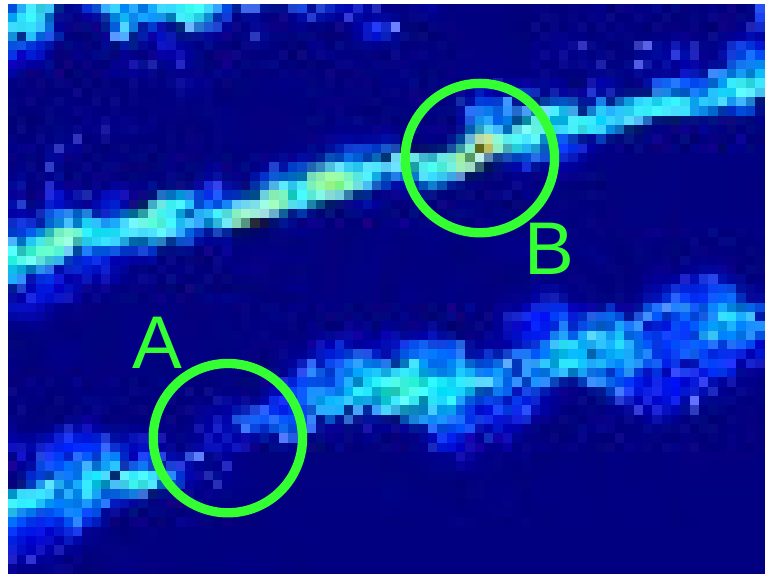
Figure 13. Critical zones of the vineyard: circle A may evidence lack of vegetation and circle B may demonstrate an over-populated zone.